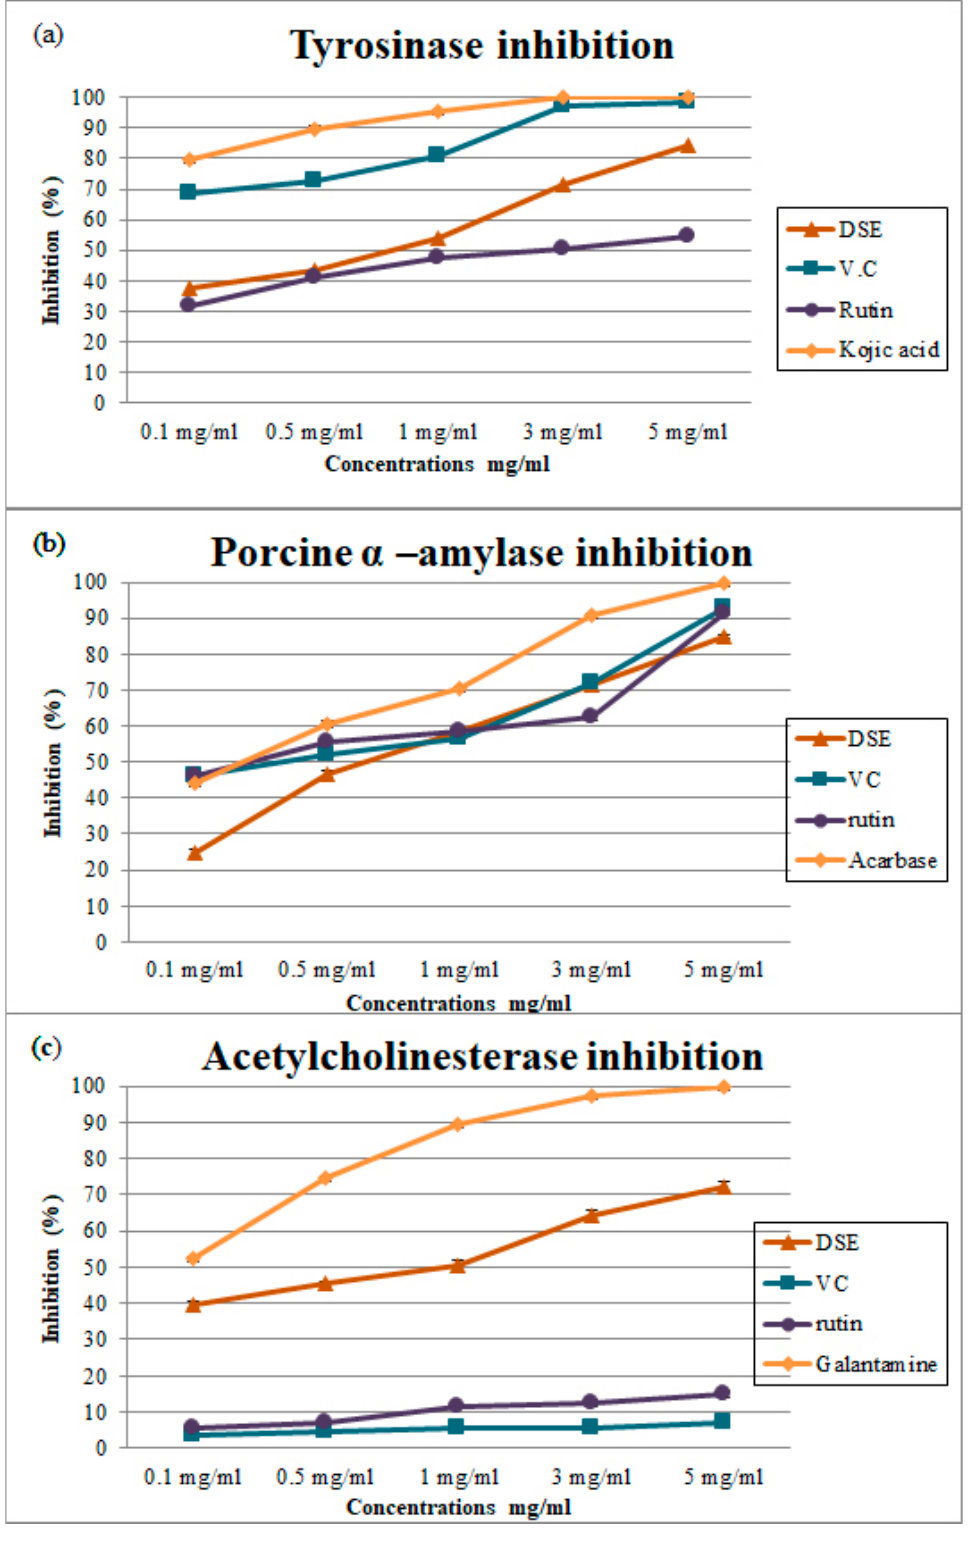
Figure 2. ( a ) Tyrosinase inhibitory activity, ( b ) Porcine α -amylase inhibitory activity, and ( c ) Ace- tylcholinesterase inhibitory activity for DSE, rutin, and vitamin C at different concentrations. Data are expressed as the mean ± SD; n = 3.